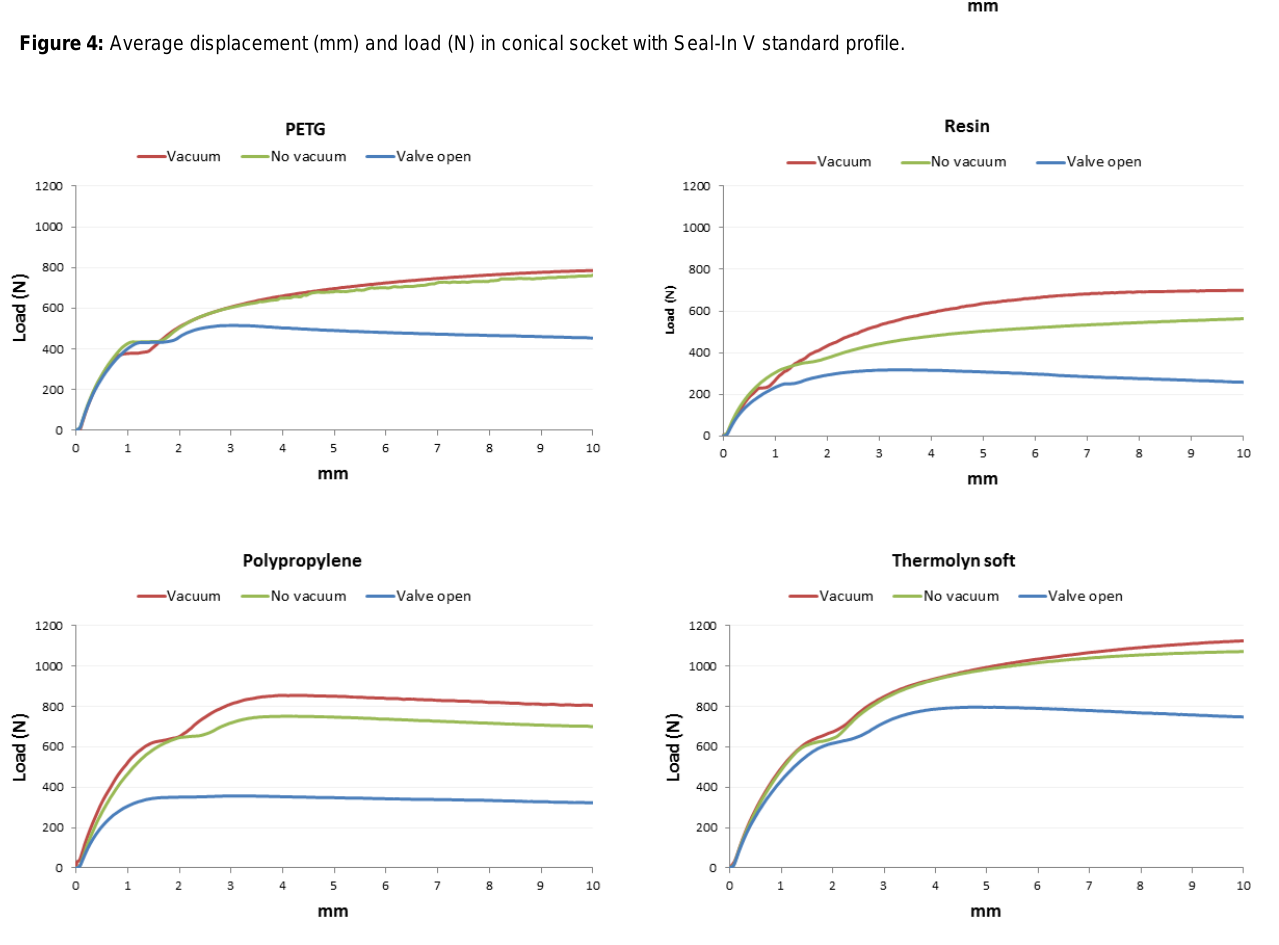
Figure 5: Average displacement (mm) and load (N) in conical socket with Seal-In V high